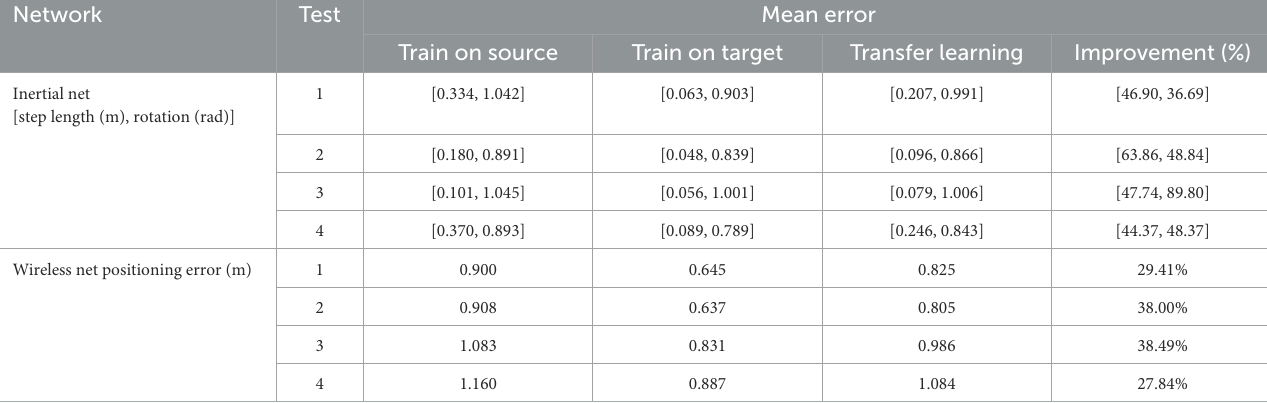
TABLE 4 Transfer learning results of inertial positioning network and wireless positioing network. Network Test Mean error Train on source Train on target Transfer learning Improvement (%) Inertial net [step length (m), rotation